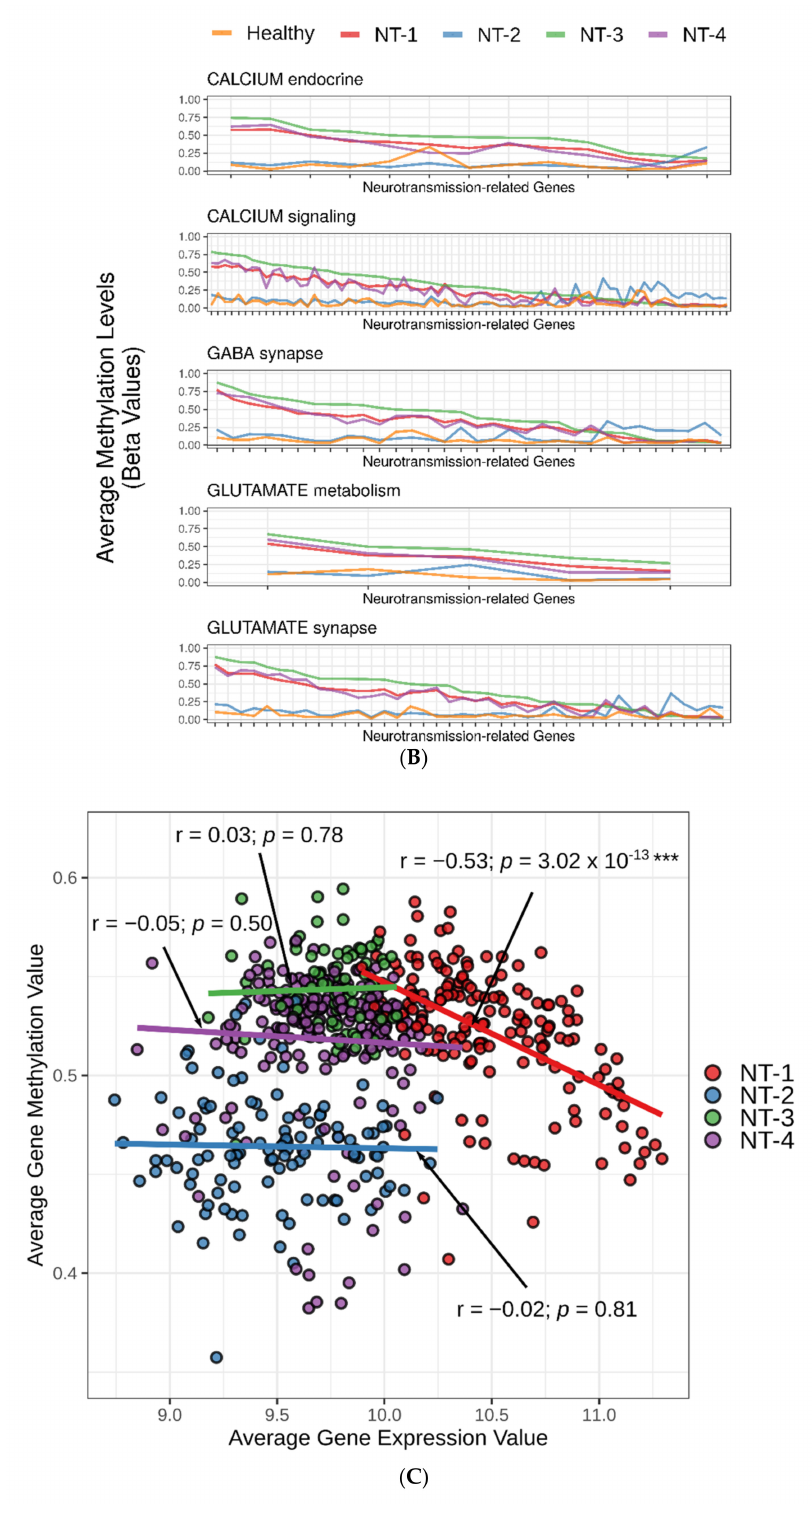
Figure 5. ( A ) DNA methylation levels associated with neurotransmission-related genes used for NT1-4 glioma unsupervised clustering. Average methylation beta values of 351 neurotransmission- related genes reflect DNA hypomethylation (beta = 0) and hypermethylation (beta = 1). Healthy samples ( n = 2) were also added to the analysis. ( B ) DNA methylation profiles associated with neurotransmission-related genes used for NT1-4 glioma unsupervised clustering. A total of 351 individual gene methylation beta-values are sorted in descending order and rated between 0 and